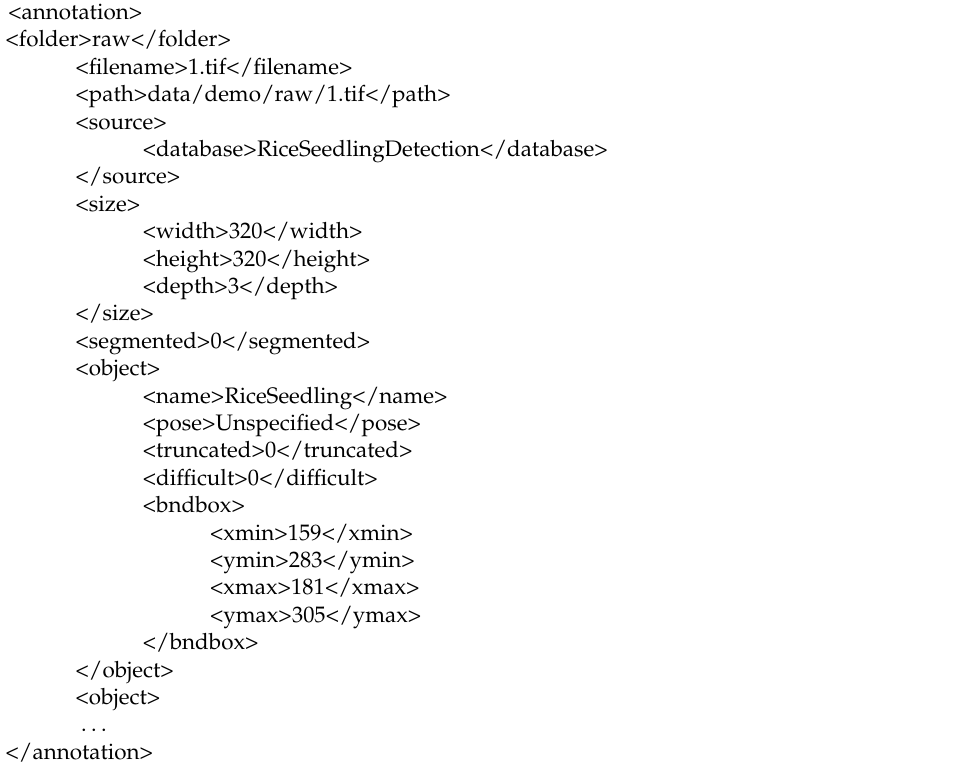
Table A1. An example of XML file of detection